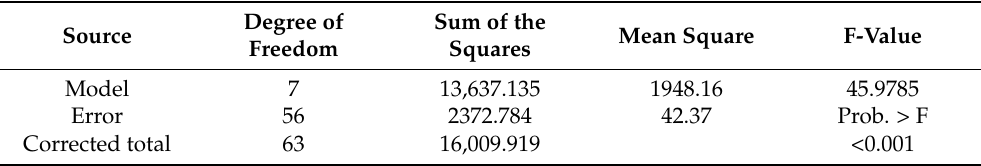
Table 8. ANOVA for total support pad